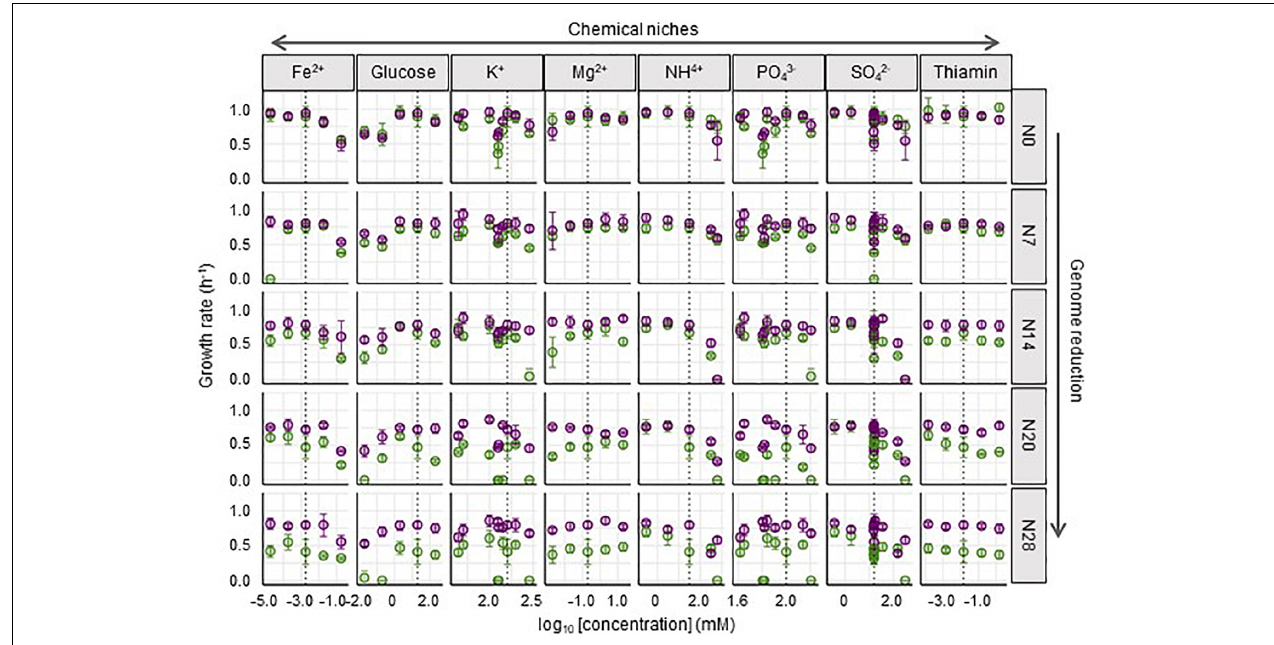
FIGURE 4 | Fitness across the concentration gradient of individual chemical niches. The mean growth rates in the 29 medium combinations are shown. The concentrations of chemical niches are shown on a logarithmic scale. The wild-type and reduced genomes are indicated as N0 and N7 ∼ N28, respectively. Purple and green represent Evos and Ancs, respectively. Standard errors of biological replications ( N > 6) are